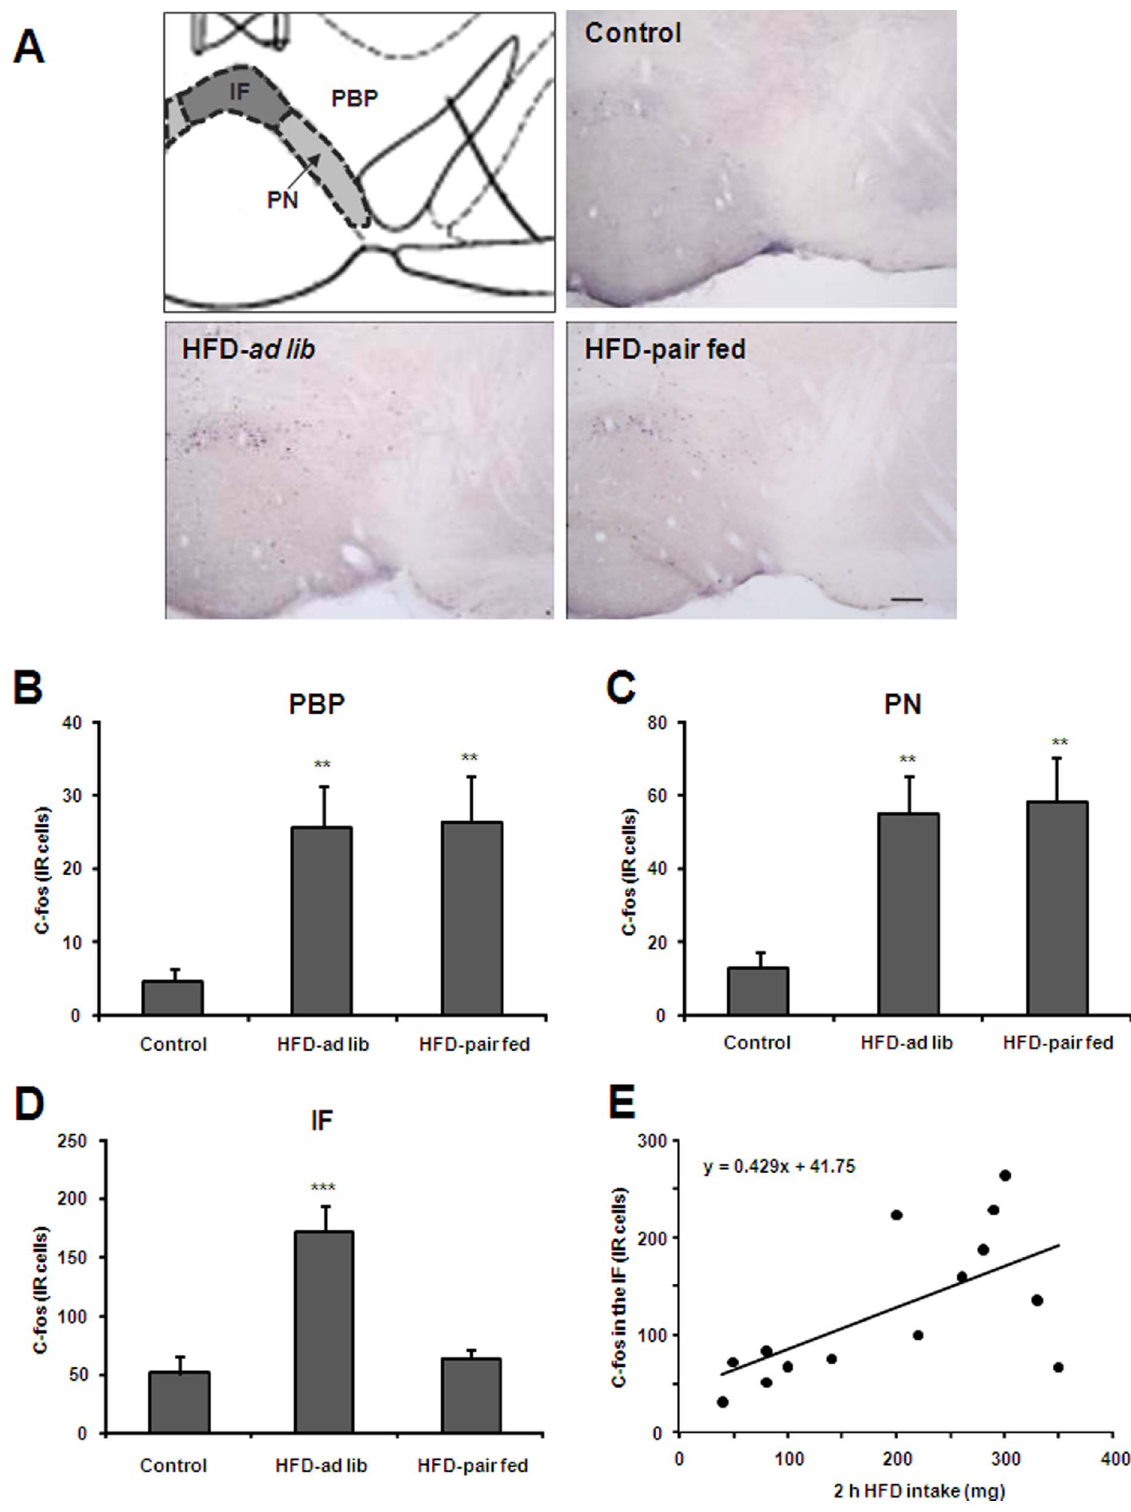
Figure 2. Acute HFD activates c-Fos in specific sub-regions of the VTA. Panel A shows a schematic diagram of VTA sub-regions in a coronal section of the mouse brain (upper left) and representative microphotographs of c-Fos (black/purple signal) immuno-staining in the VTA of control (upper right), HFD- ad lib (bottom left) and HFD-pair-fed (bottom right) groups. Scale bar: 100 m m. Panels B-D show quantitative analysis of c-Fos staining in specific PBP (B), PN (C) and IF (D) sub-regions of the VTA. Histograms depict the total number of c-Fos-IR neurons, expressed as cells per coronal section, for each experimental group. Values are the mean 6 SEM. **, p , 0.01 vs. control group. ***, p , 0.001 vs. control group. Panel E shows the correlation between 2 h food intake and c-Fos-IR cells in the IF sub-region of the VTA in HFD- ad lib group (r=0.628). Each point represents a measurement from a single animal. doi:10.1371/journal.pone.0087478.g002 PLOS ONE | www.plosone.org